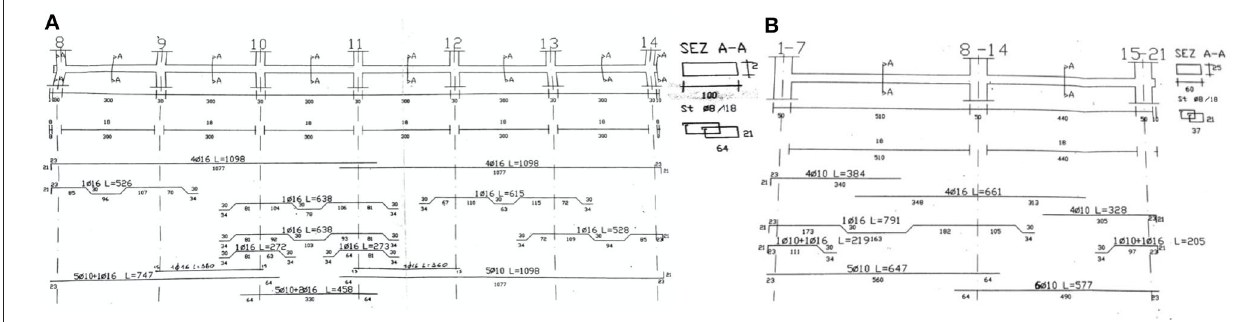
FIGURE 2 | Existing beams. Details of longitudinal and transverse reinforcements related to (A) principal beams (i.e., supporting the joists) and (B) secondary ones (original drawings).